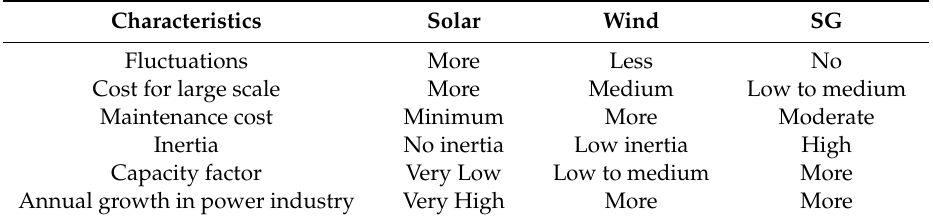
Table 1. The comparison of renewable energy sources (RES) with synchronous generator (SG) [5].